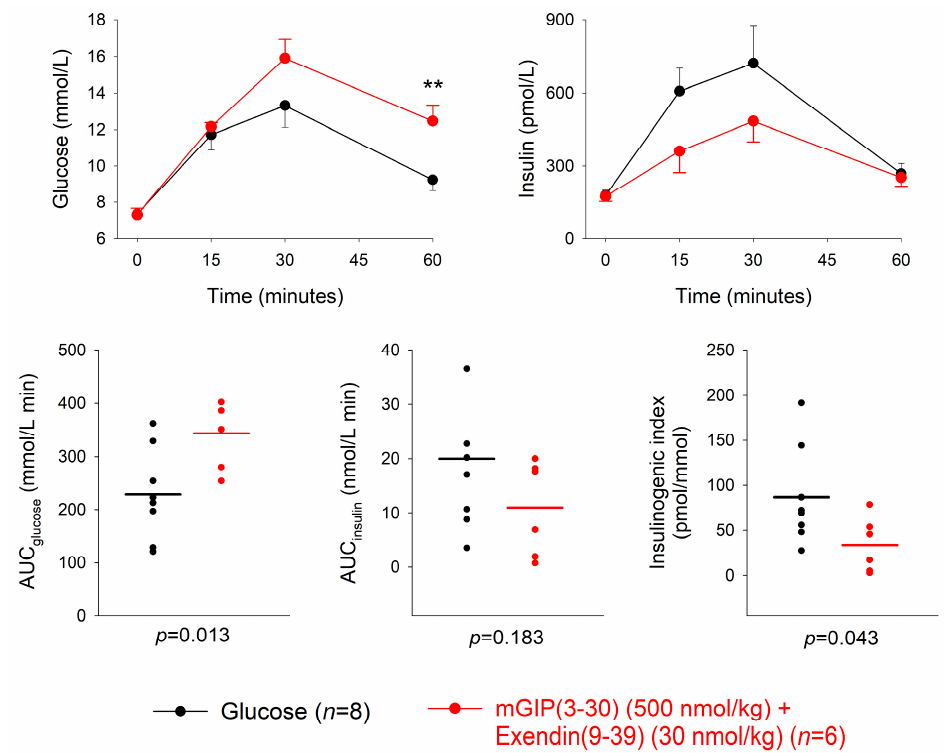
Figure 3. Glucose and insulin levels, and individual data points for AUC glucose , AUC insulin and insulinogenic index after combined intravenous administration of the GIP receptor antagonist mGIP(3-30) (500 nmol/kg) and the GLP-1 receptor antagonist exendin(9-39) (30 nmol/kg) or saline four minutes after oral administration of 50 mg glucose in normal mice. Means ± SEM are shown. Asterisks indicate the probability level of random difference between mGIP(3-30) + exendin(9-39) versus the glucose control; ** p < 0.01; exact p levels see results section; n indicates number of animals.